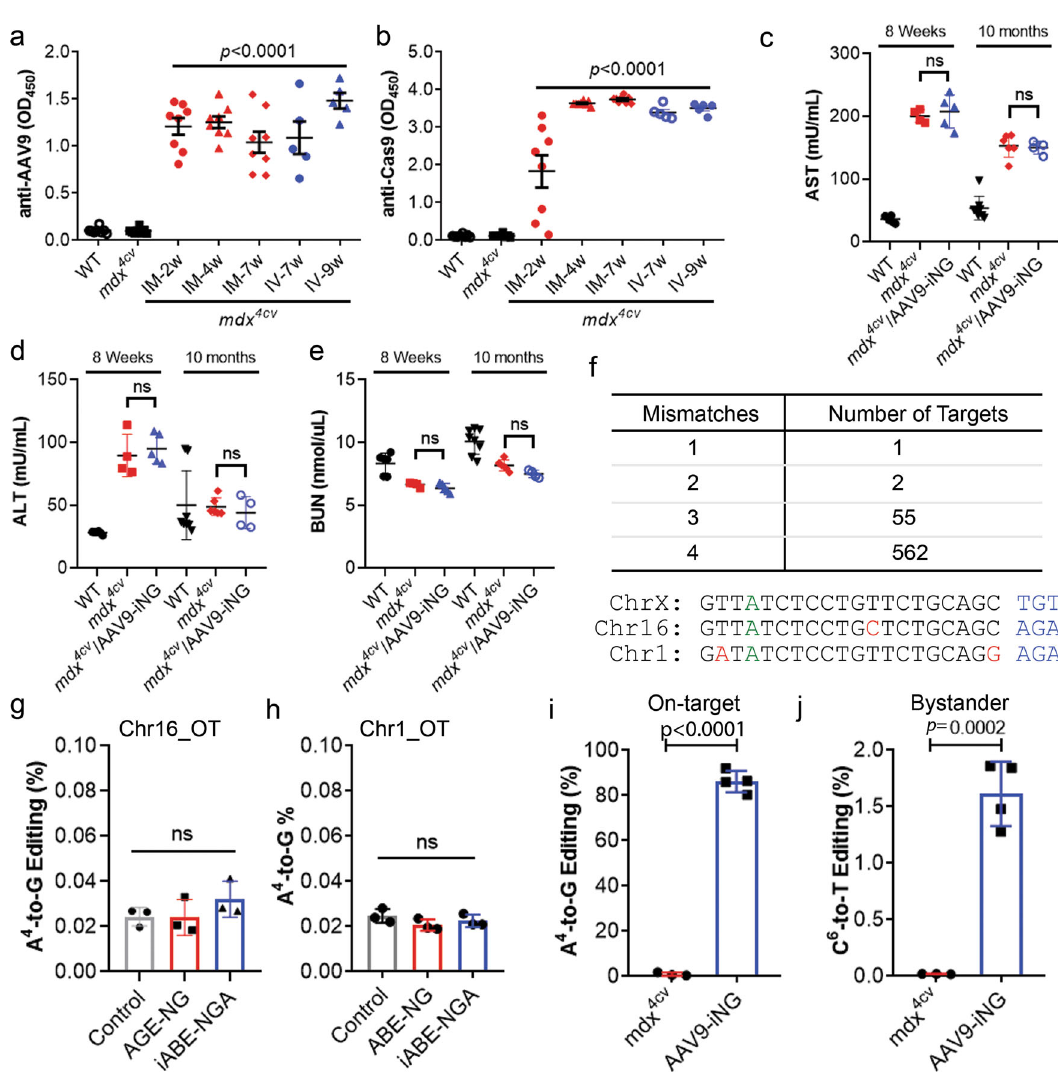
Fig. 7 Host immune response, toxicity and off-target studies of AAV9-iNG therapy in mdx 4 cv mice. a , b Host immune response to AAV9 capsid and the base editor transgene (anti-Cas9). IM intramuscular injection, IV intravenous injection. n = 5 mice for IV groups and eight mice/group for the rest; one-way ANOVA with Turkey ’ s multiple comparisons test. Data are mean ± s.e.m. c – e Measurements of serum AST ( c ), ALT ( d ) and BUN ( e ) of mice treated with or without AAV9-iNG. n = 6 WT, 4 mdx 4cv and 5 AAV9-iNG treated, 10 weeks; n = 8 WT, 6 mdx 4cv and 4 AAV9-iNG treated, 10 months. ns not statistically signi fi cant (one-way ANOVA with Turkey ’ s multiple comparisons test). Data are mean ± SD. f Predicted off-target sites with different number of mismatches from the mdx 4cv target gRNA, and the sequences of two most similar off-target sites located on chromosome 16 and 1, respectively. g , h Quanti fi cation of deep sequencing reads of the genomic DNA PCR amplicons of the chromosome 16 off-target site ( g ) or the chromosome 1 off-target site ( h ) from Neuro-2a cells transfected with ABE-NG, iABE-NGA or control plus the gRNA. n = 3/group. ns not signi fi cant (one-way ANOVA with Turkey ’ s multiple comparisons test). Data are mean ± SD. i Quanti fi cation of the A 4 -to-G editing in mdx 4cv mice treated with or without AAV9-iNG. n = 3 mdx 4cv and 4 AAV9-iNG treated; two-tailed unpaired t test. Data are mean ± SD. j Quanti fi cation of the bystander C 6 -to-T editing in mdx 4cv mice treated with or without AAV9-iNG. n = 3 mdx 4cv and 4 AAV9-iNG treated; two-tailed unpaired t test. Data are mean ±